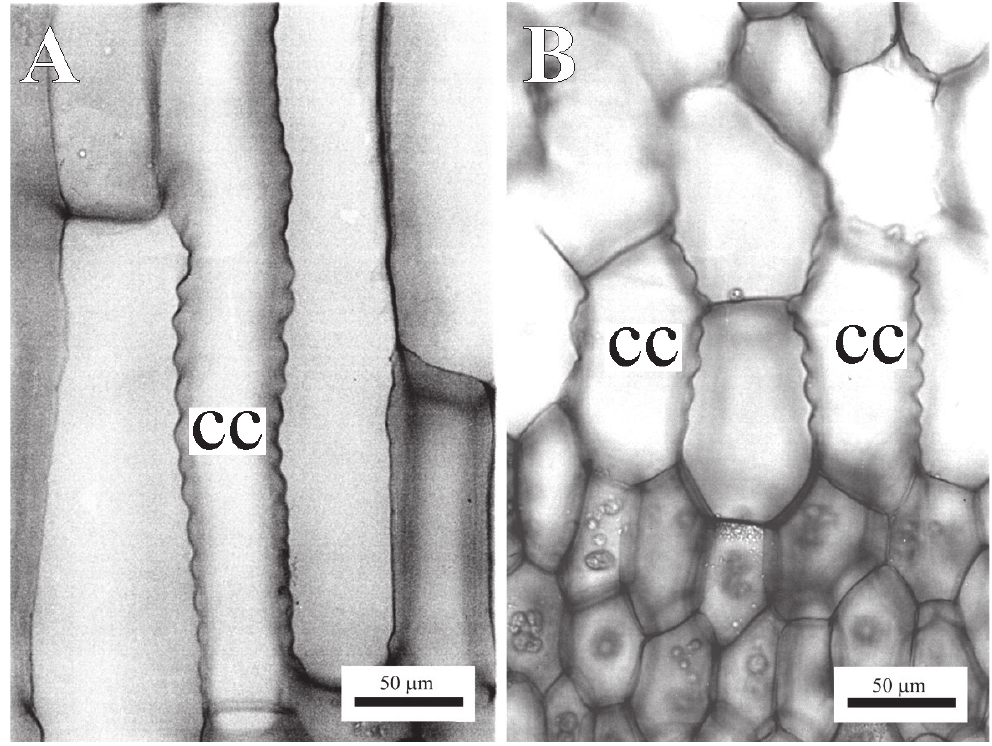
Figure 6 - Detail of Neoregelia cruenta water storage parenchyma showing concertina-like cells (cc). At middle portion (A) and apex (B)